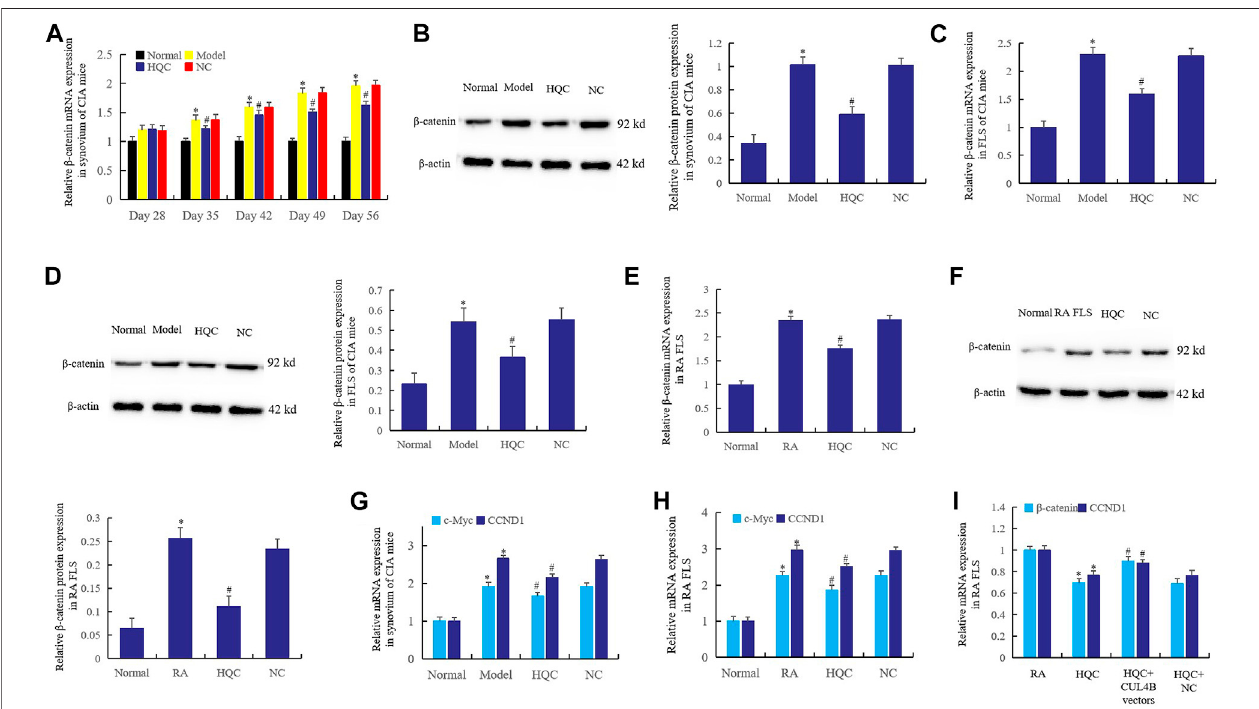
FIGURE 4 | HQC inhibited the Wnt signaling pathway in RA pathogenesis. The effect of HQC on the expression of β -catenin was detected in synovium from CIA model mice by real-time qPCR (A) and western blotting (B) ; Real time qPCR (C) and western blotting (D) were used to detected the effect of HQC on the expression of β -catenin in CIA FLS; the effect of HQC on the β -catenin was detected in RA FLS by real-time qPCR (E) and western blotting (F) ; (G) : the expression of c-Myc and CCND1 in the synovium of CIA mice was detected by real-time qPCR; the expression of c-Myc and CCND1 in RA FLS was detected by real-time qPCR (H) ; the interference of CUL4B vectors toHQC wasdetected by real-time qPCR (I) . *Model/RA FLS group was compared with normal group; #HQCgroup was compared with model/RA FLS group. For (I) , *HQC group was compared with RA FLS group; # HQC + CUL4B vector group was compared with HQC